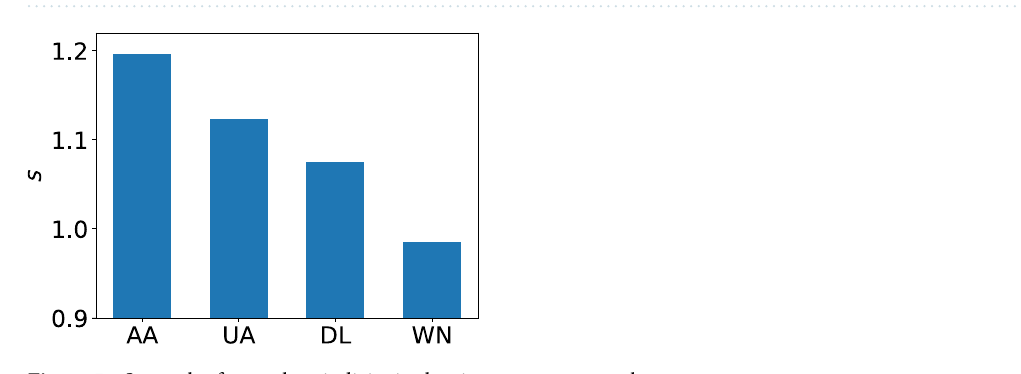
Figure 5. Strength of annual periodicity in the air transport